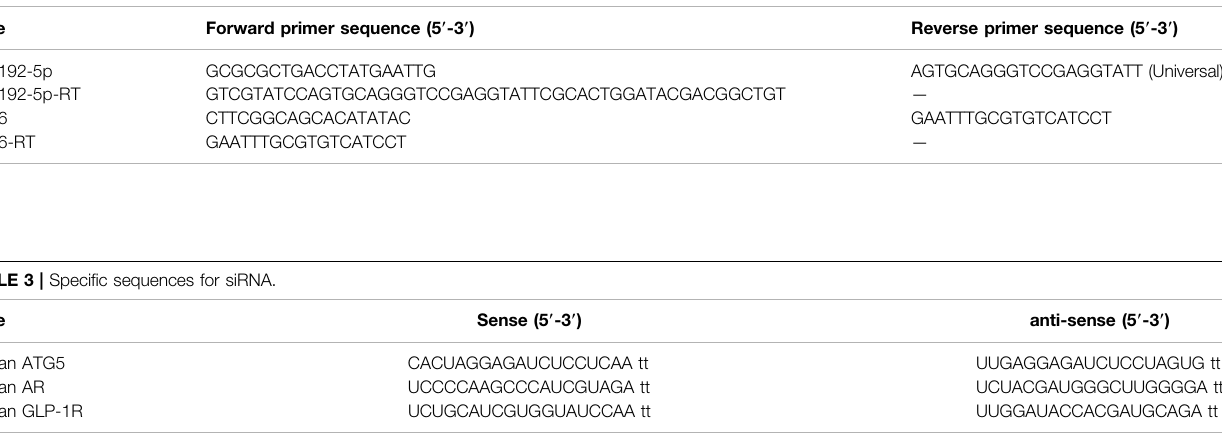
TABLE 2 | miRNA primer sequences for PCR.